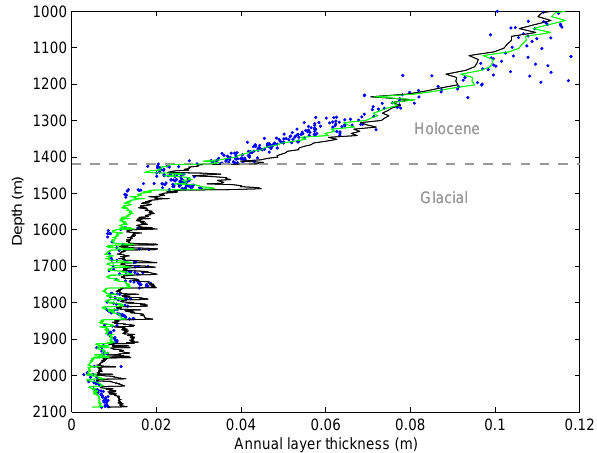
Fig. 6. Observed NEEM annual layer thicknesses (blue) and an- nual layer thicknesses inferred by applying the thinning function obtained from the D–J model to the accumulation rates calculated from the δ 18 O record (black). By reducing the calculated accumu- lation rates by 30% in the glacial and phasing out the reduction linearly from 30% at 11.7kab2k to zero at 7.9kyrb2k, a signifi- cantly better fit to the observed annual layer thicknesses is obtained (green).